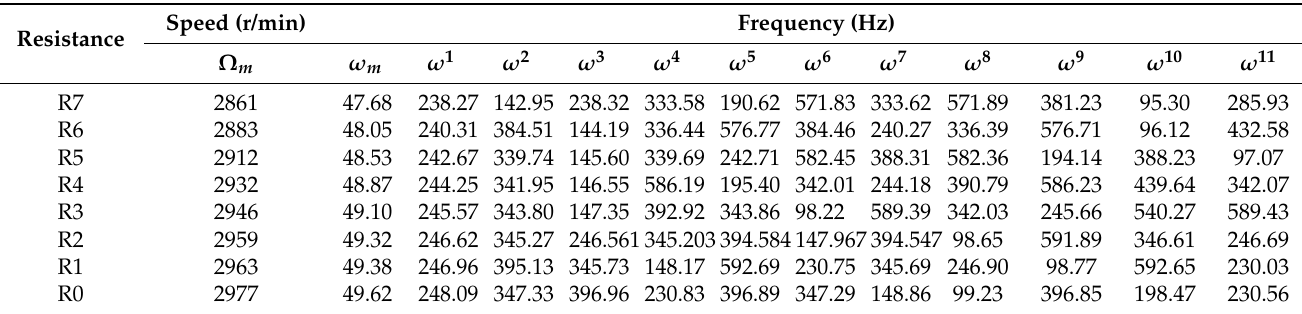
Table 5. DC generator coupled to the motor shaft: rotor shaft mechanical frequency and values of the frequencies corresponding to the 11 peaks of the magnitude of the spectrum of the noise signal. Speed (r/min) Frequency (Hz) Resistance